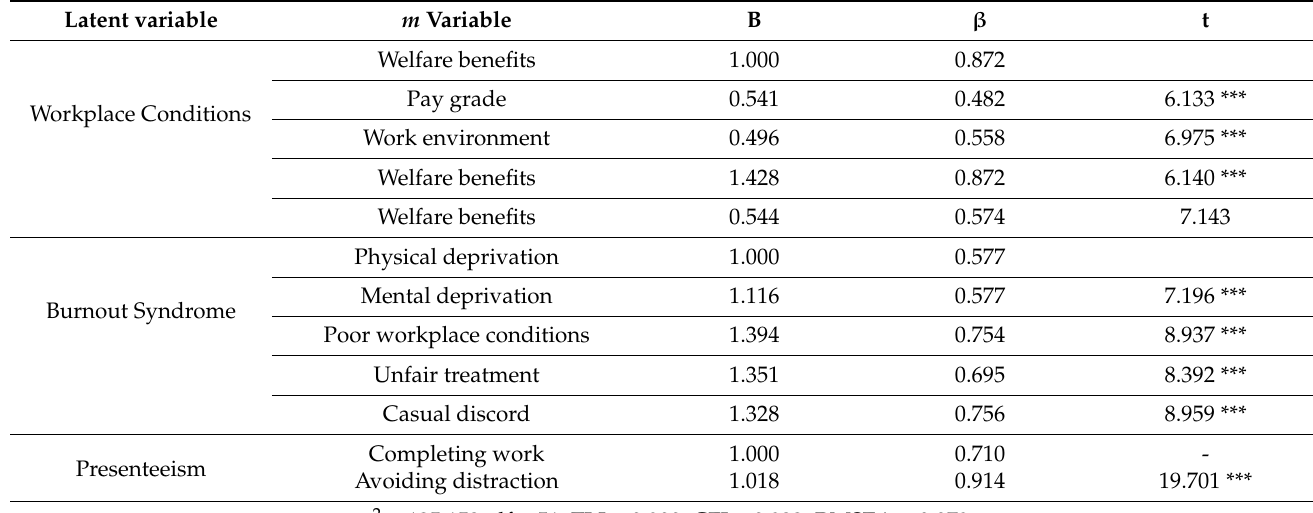
Table 5. Measurement model